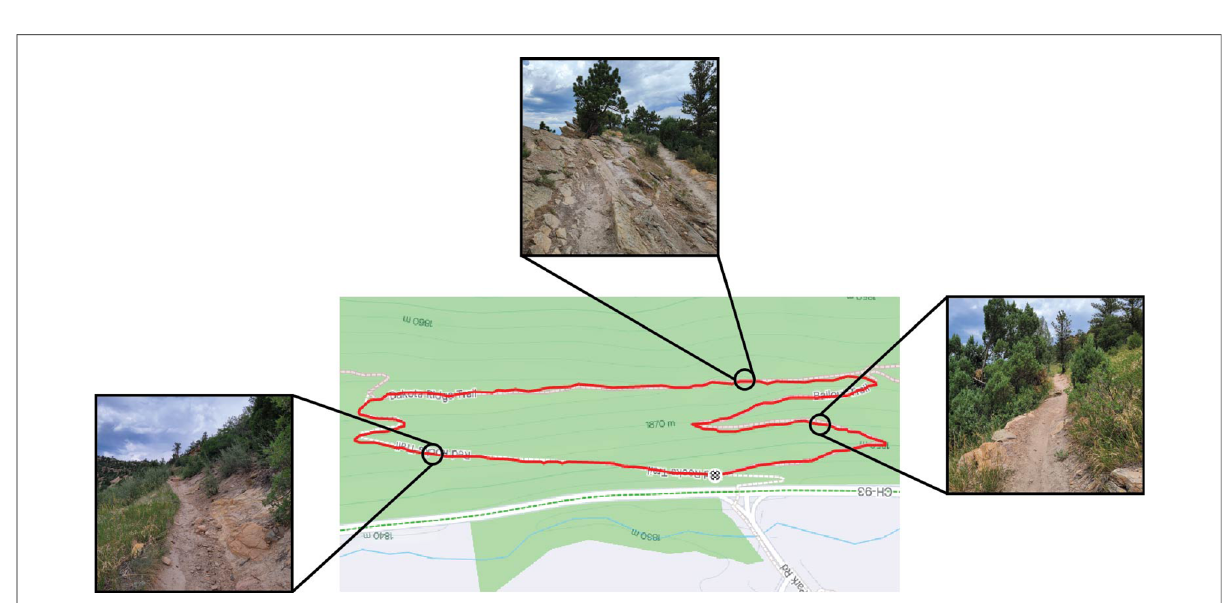
FIGURE 2 Topographic map with route subjects ran (shown in red). Subjects ran the route in a counter-clockwise fashion. Pictures show example terrain of the different trail sections: uphill (right), top (top), and downhill (left). The average uphill slope was +4°, the average top slope was +2°, and the average downhill slope was − 6°. Topographic map was used with permissions from Strava